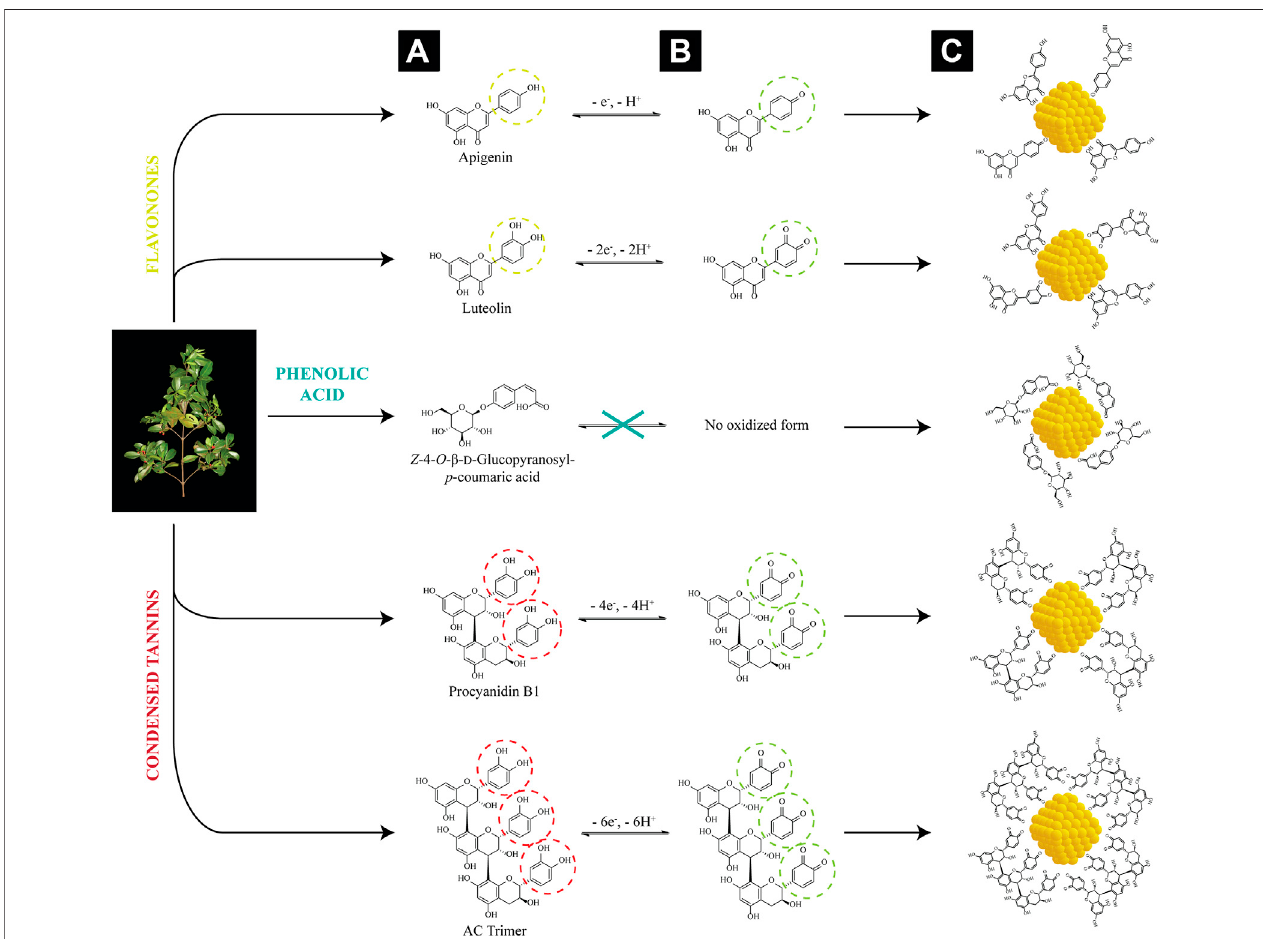
FIGURE 5 | Proposed mechanism for the reduction and stabilization of AuNPs by polyphenolic compounds of C. brachiata : (A) previously reported phenolics and fl avonoids from the leaf extract of C. brachiata , (B) their corresponding oxidized forms, and (C) and their complexation on the AuNP surfaces.